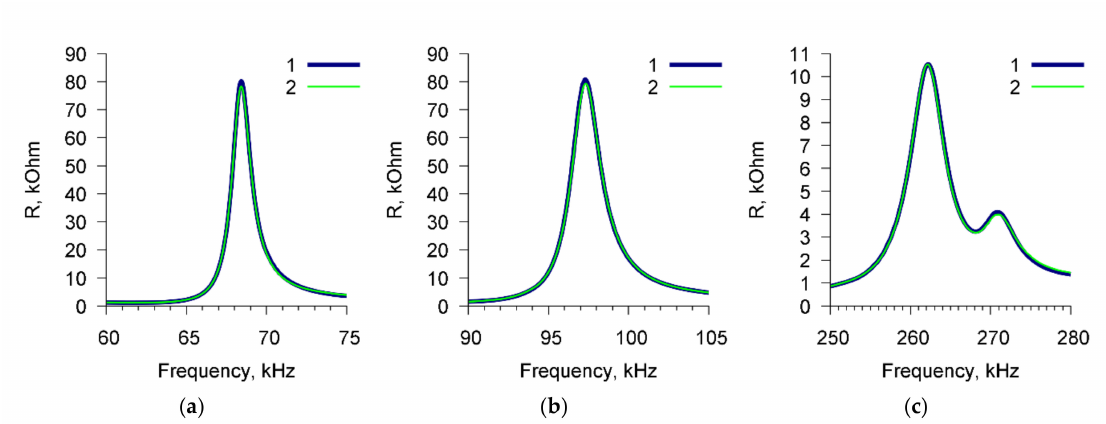
Figure 4. The frequency dependencies of the real part of the electrical impedance of PZT resonator with container loaded by E. coli K-12 suspension before (curve 1) and after (curve 2) adding the Abs specific to A. brasilense Sp7. The cell concentration was 10 3 cells / mL, the concentration of Abs was 4 µ g / mL. ( a ) Peak near 68.7 kHz, ( b ) peak near 97.8 kHz, ( c ) peak near 264 kHz.